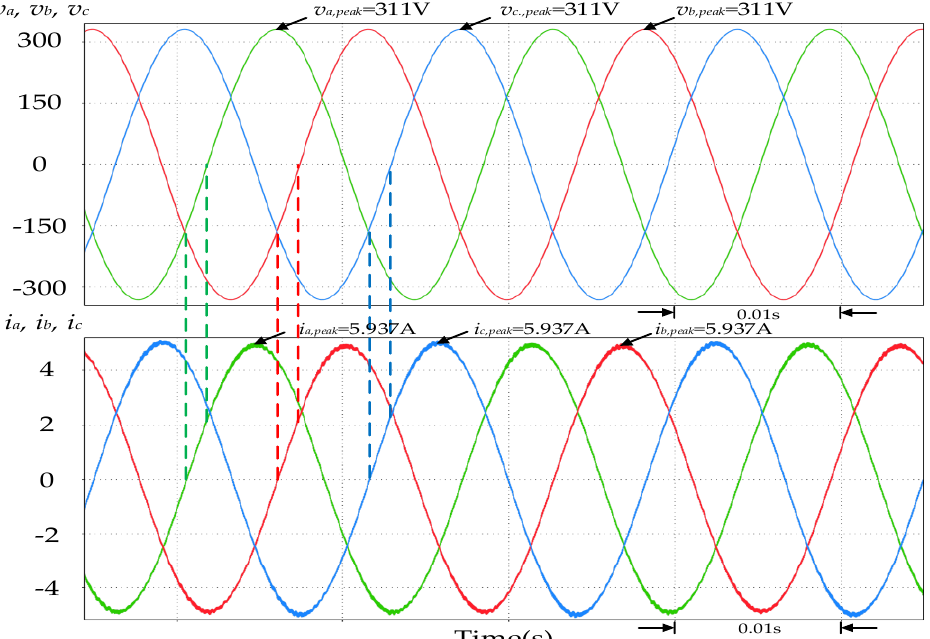
Figure 16. The three-phase output voltage and current waveforms of the smart inverter when the per-unit value of mains voltage was between 0.97p.u. and 1p.u.